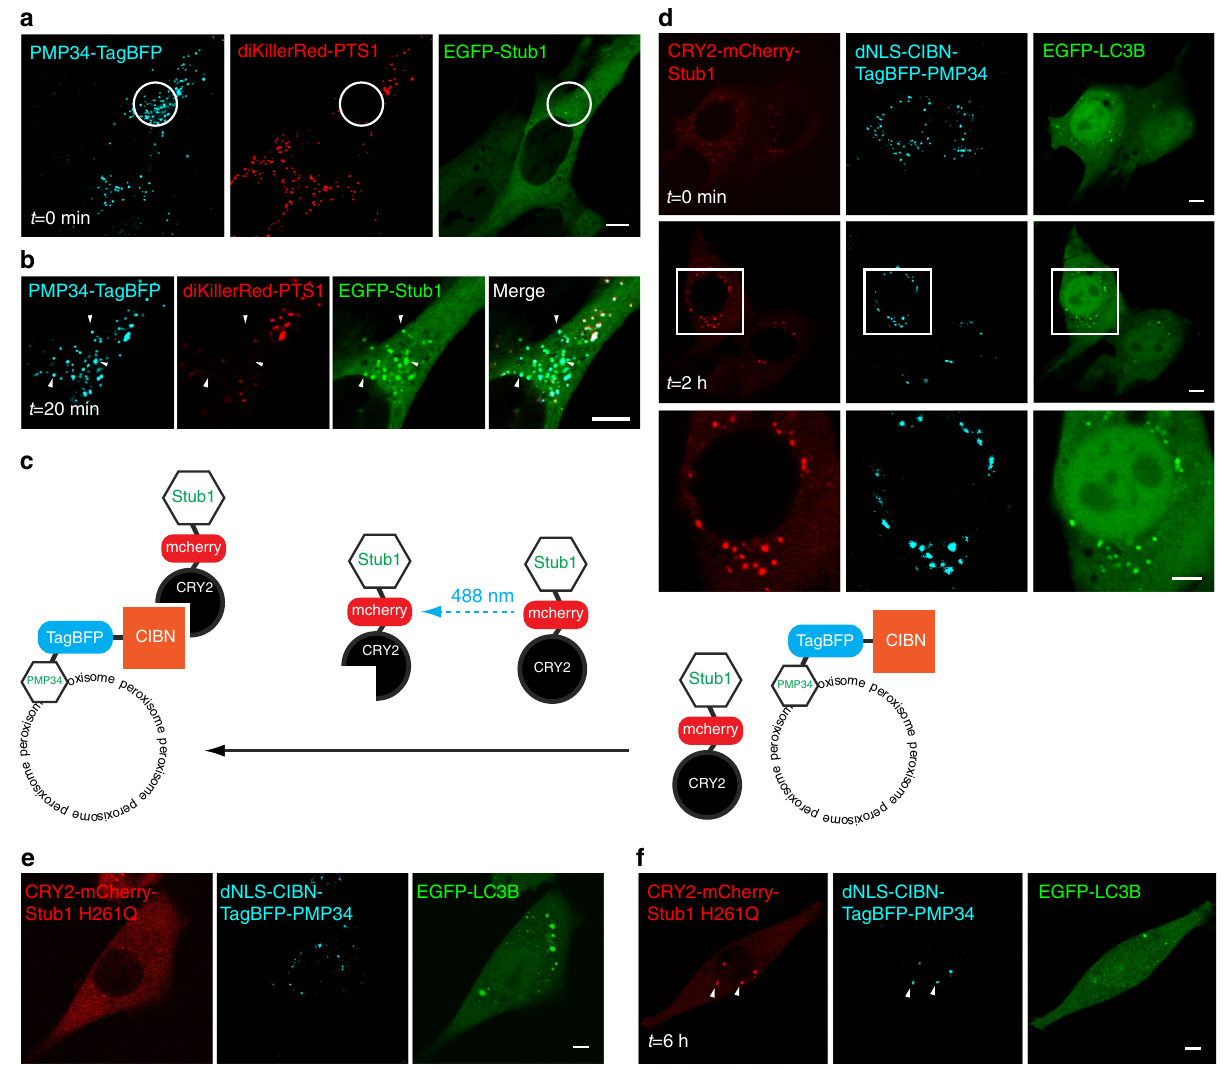
Fig. 3 Peroxisomal Stub1 drives pexophagy. a Peroxisomes within the white circular region in a NIH3T3 cell expressing diKillerRed-PTS1, PMP34-TagBFP, and EGFP-Stub1 were 559 nm illuminated, leading to the immediate loss of their diKillerRed-PTS1 fl uorescence. b EGFP-Stub1 speci fi cally accumulated on 559 nm illuminated peroxisomes in the cell in a (white arrowheads, 20 min after 559 nm illumination, n = 16 cells). c Scheme to target Stub1 onto non- stressed peroxisomes. Upon 488 nm light illumination, CRY2-mCherry-Stub1 recruits to the surface of dNLS-CIBN-TagBFP-PMP34-labeled peroxisomes through CRY2/CIBN dimerization. d A NIH3T3 cell expressing CRY2-mCherry-Stub1, EGFP-LC3B, and dNLS-CIBN-TagBFP-PMP34 was whole-cell illuminated with 488 nm (19 μ W, 2 min), leading to CRY2-mCherry-Stub1 recruitment onto all peroxisomes. This led to the EGFP-LC3B accumulation on all peroxisomes (top row: before 488 nm illumination; middle row: 2 h after illumination; bottom row: magni fi ed view of the white square region in the middle row, n = 5 cells). e , f As in d , but with CRY2-mCherry-Stub1 H261Q. In this case, EGFP-LC3B did not accumulate on peroxisomes either before ( e ) or after illumination ( f , white arrowheads, up to 6 h after 488 nm illumination, n = 12 cells). All scale bars: 5 μ